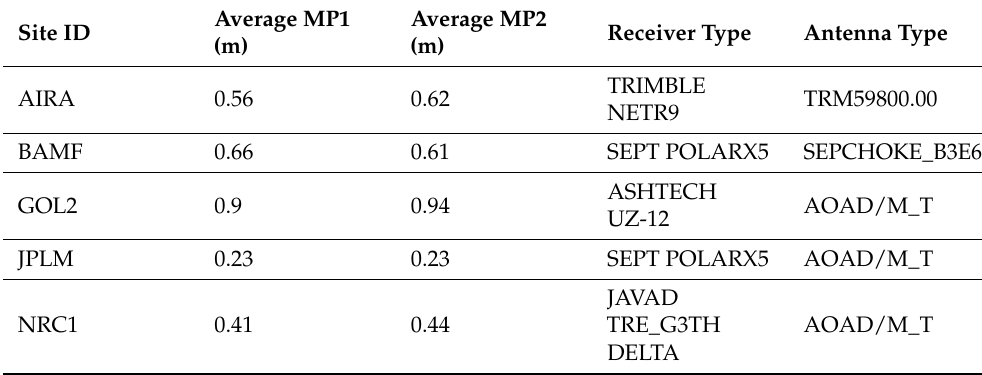
Table 1. Examples of daily average MP1 and MP2 of five IGS tracking